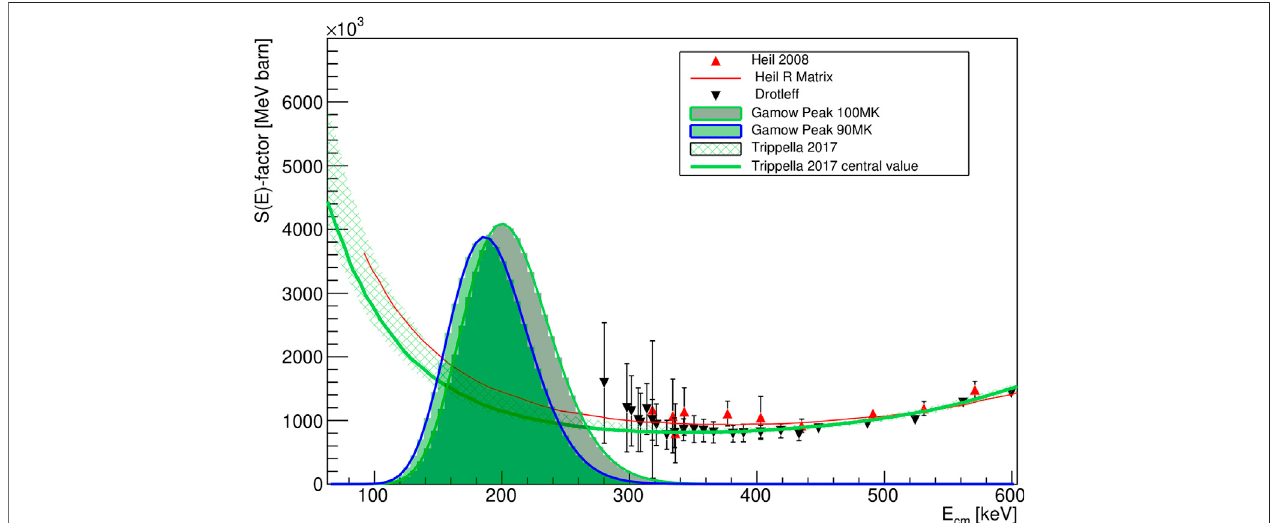
FIGURE 5 | Selection of most recent 13 C( α ,n) 16 O measurements. Among the direct measurements, the Drotleff and the Heil data are represented, indicated by blacktrianglesandredtriangles,respectively.ThesolidredcurveindicatestheRmatrixextrapolationbyHeil.ThemostrecentindirectmeasurementbyTHMbyTrippella et al. is indicated by the green squared area and the central value is the green curve. In the plot, the Gamow window for two different stellar scenarios is drawn.